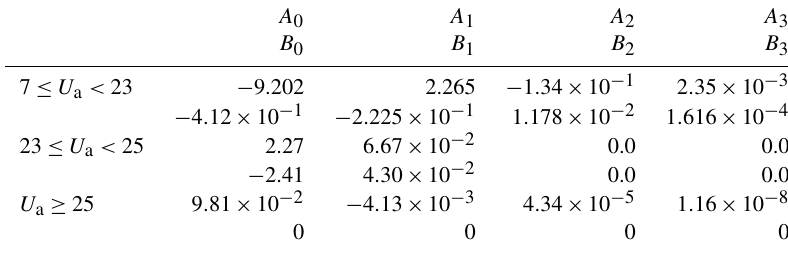
Table A1. Coefficients of the polynomial functions A and B, depending on the wind speed